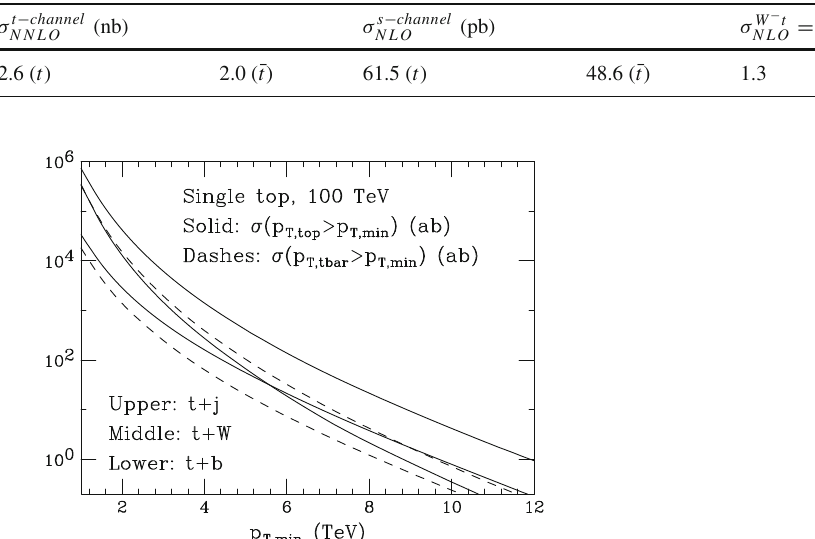
Fig. 6.7 Integrated top p T spectra in the various single-top production channels, at FCC-hh. For the tW process only one line is shown, since σ( tW − ) = σ( ¯ tW + )